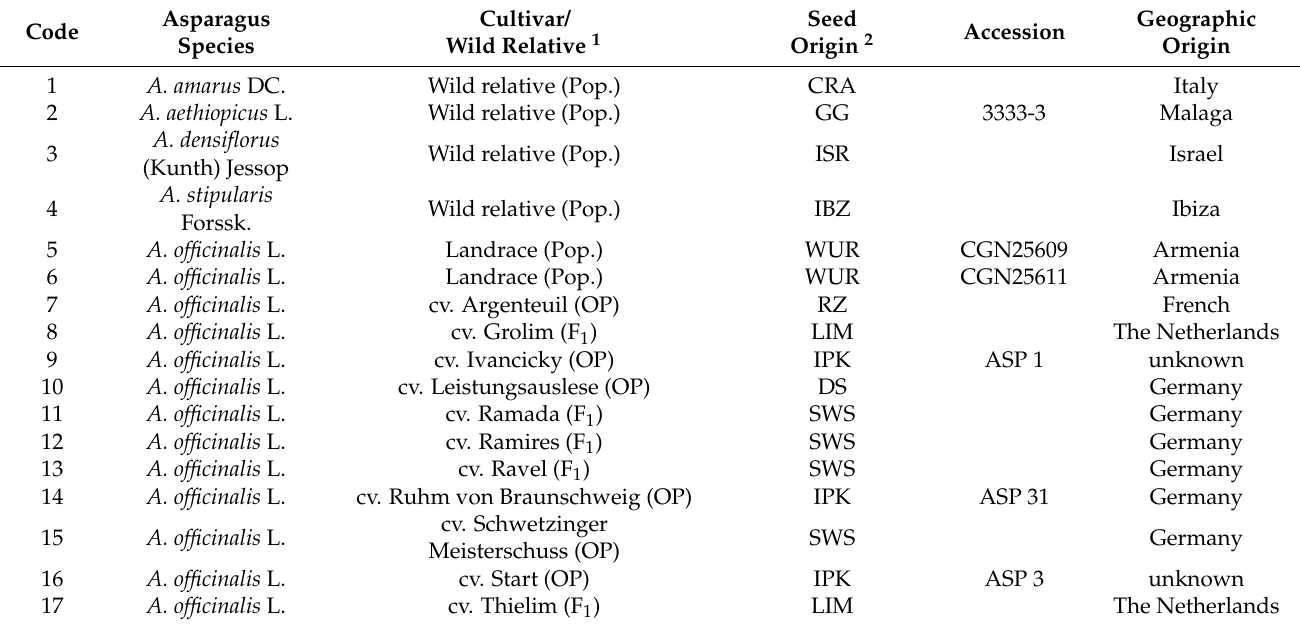
Table 1. Asparagus species evaluated for resistance to Fusarium oxysporum